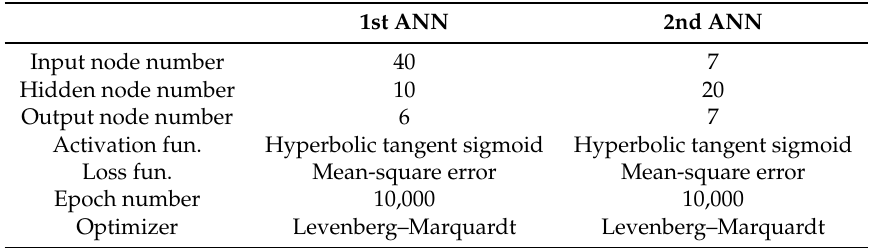
Figure 16. Performance results of proposed dual-network method and single-network approach: ( a ) mean error; ( b ) mean success rate. Table 5. Details of the two